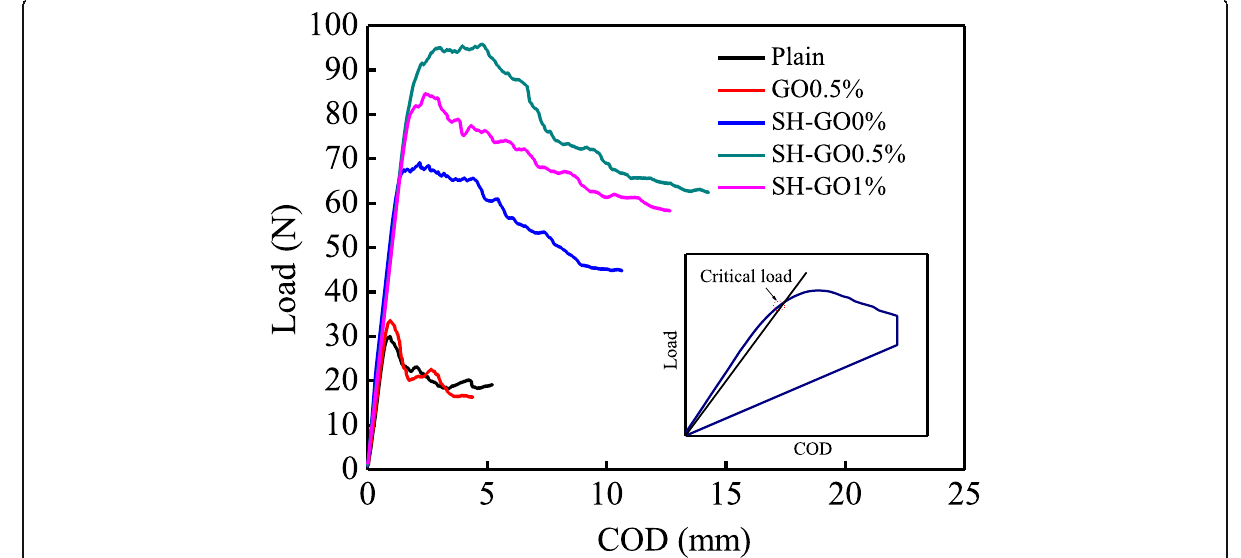
Fig. 8 Representative load and crack opening displacement ( P -COD) curves for different specimens during DCB tests